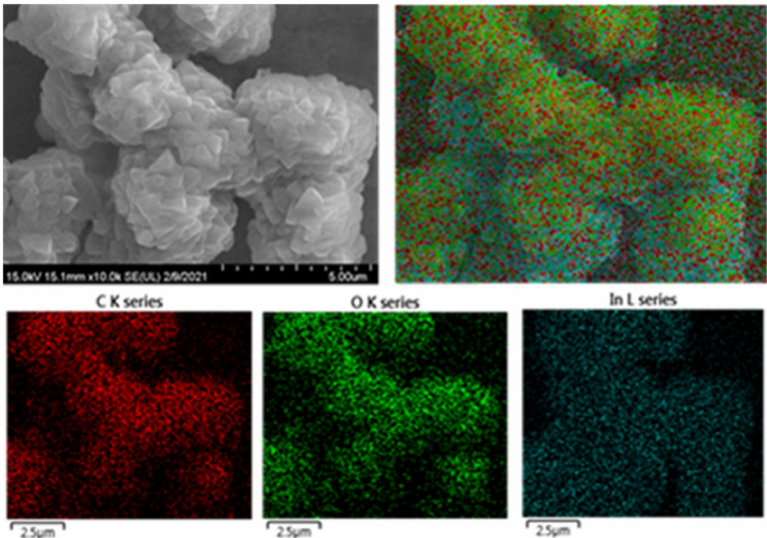
Figure 8. SEM and elemental mapping images of the In 2 O 3 -MF catalyst after five